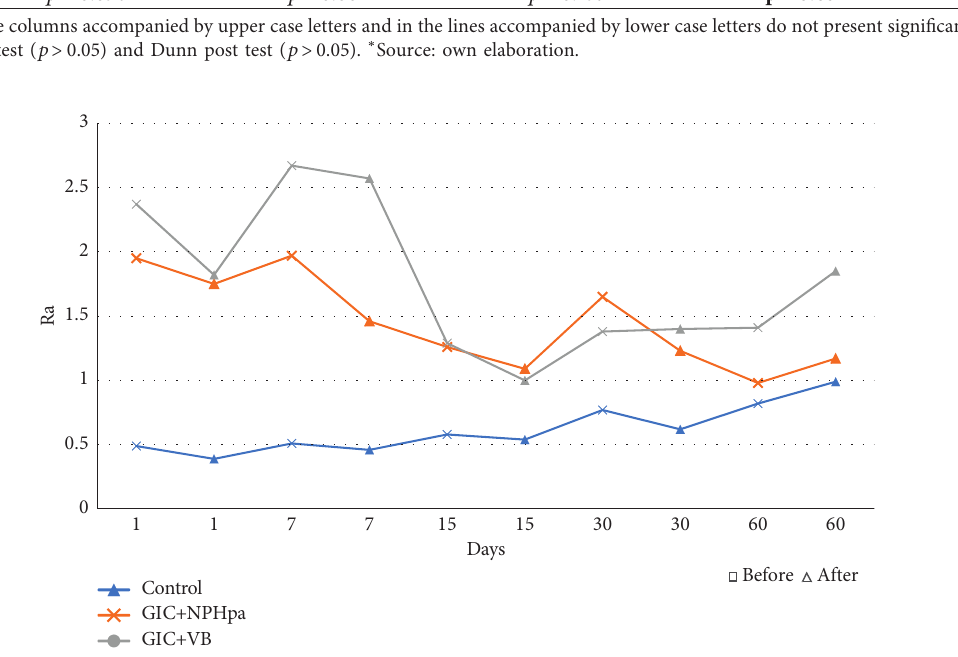
Figure 2: Variability of surface roughness (Ra) before and after brushing over time (days).